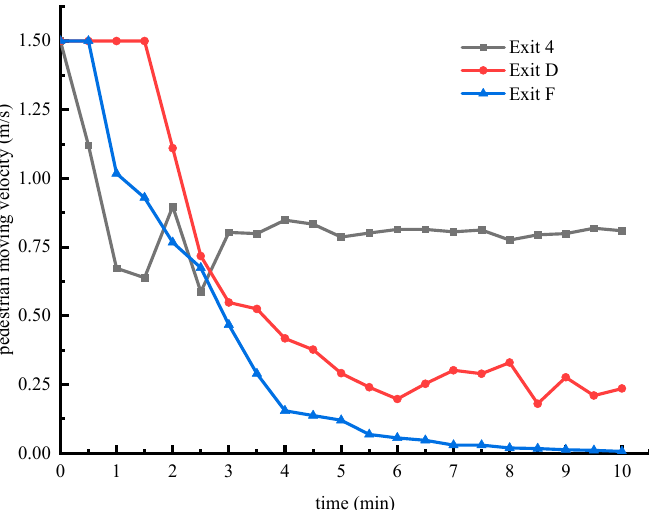
15 of 19 All emergency safety passages entrances were inundated (Figure 14); emergency safety Passages ① ~ ④ were designed to be long and narrow with multi-run stairs, so the